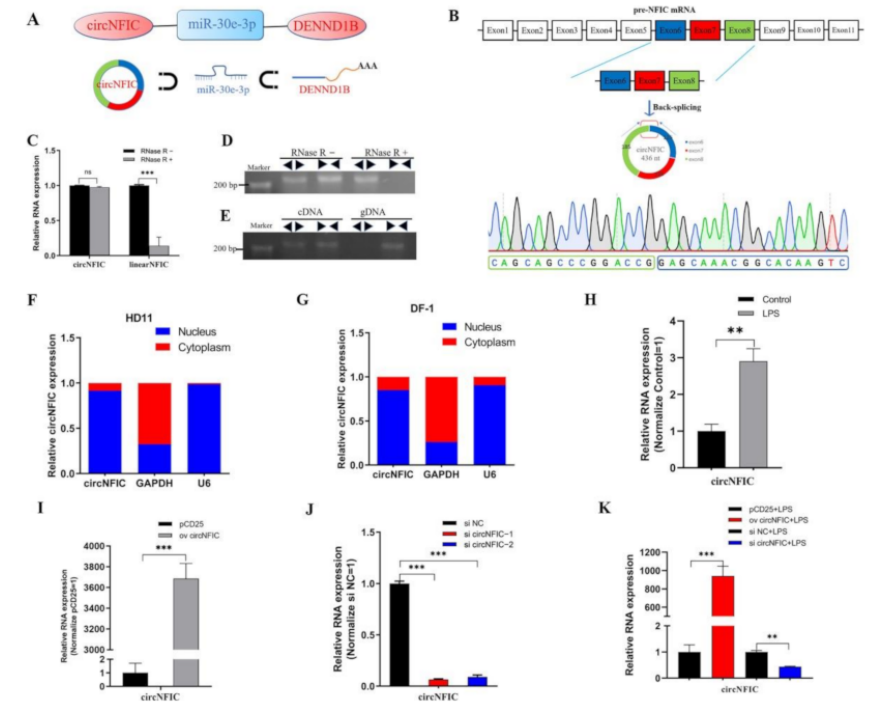
Figure 1. Characteristics and subcellular localization of circNFIC. ( A ) The differently expressed regulation interaction network (up-regulation and down-regulation transcripts were highlighted in red or blue, respectively). ( B ) In the formation of circNFIC, the BSJ was amplified and validated by divergent primers and sanger sequencing. ( C , D ) The resistance of circNFIC was detected by the RNase R digestion assay. ( E ) Divergent primers amplified circACSL1 from cDNA, but not from gDNA. ( F , G ) The separation of nuclear and cytoplasmic was performed in HD11 cells and DF-1 cells. ( H ) The expression of circNFIC was induced by LPS stimulation. ( I , J ) The efficiency of overexpression and knockdown of circNFIC was detected by qRT-PCR. ( K ) The efficiency of overexpression and knockdown of circNFIC was detected by qRT-PCR during LPS stimulation. Data are presented as mean ± SEM ( n ≥ 3 biologically independent samples). ** p < 0.01; *** p < 0.001 (Student’s t